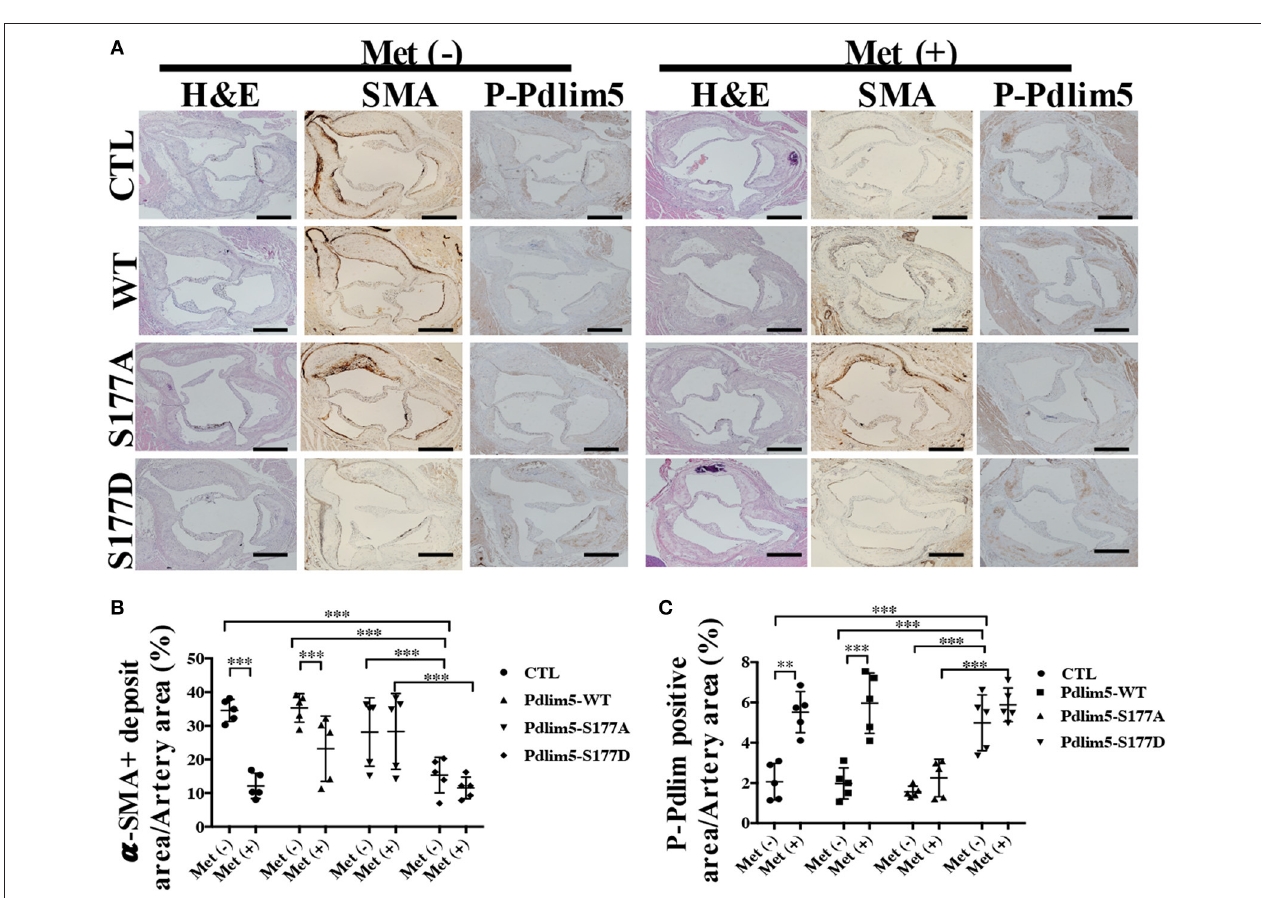
FIGURE 5 | The phosphorylation of Pdlim5 induced by AMP-activated protein kinase was related to metformin’s anti-atherosclerosis function. (A) Representative images of H&E staining and immunostaining of α -SMA and phosphorylated Pdlim5 at the aortic root of diabetic ApoE − / − mice. Scale bar = 200 µ m. (B) Quantification of α -SMA-positive area in the aortic root. Data are representative of means ± SEM from five independent experiments. The significance of differences between the series of results was assessed using one-way analysis of variance, followed by a post-hoc comparison with Dunnett’s method for multiple comparisons. *** P < 0.001, n = 5. (C) Quantification of phosphorylated Pdlim5-positive area in the aortic root. Data are representative of means ± SEM from five independent experiments. The significance of differences was assessed using one-way analysis of variance, followed by a post-hoc comparison with Dunnett’s method for multiple comparisons. ** P < 0.01, *** P < 0.001, n =